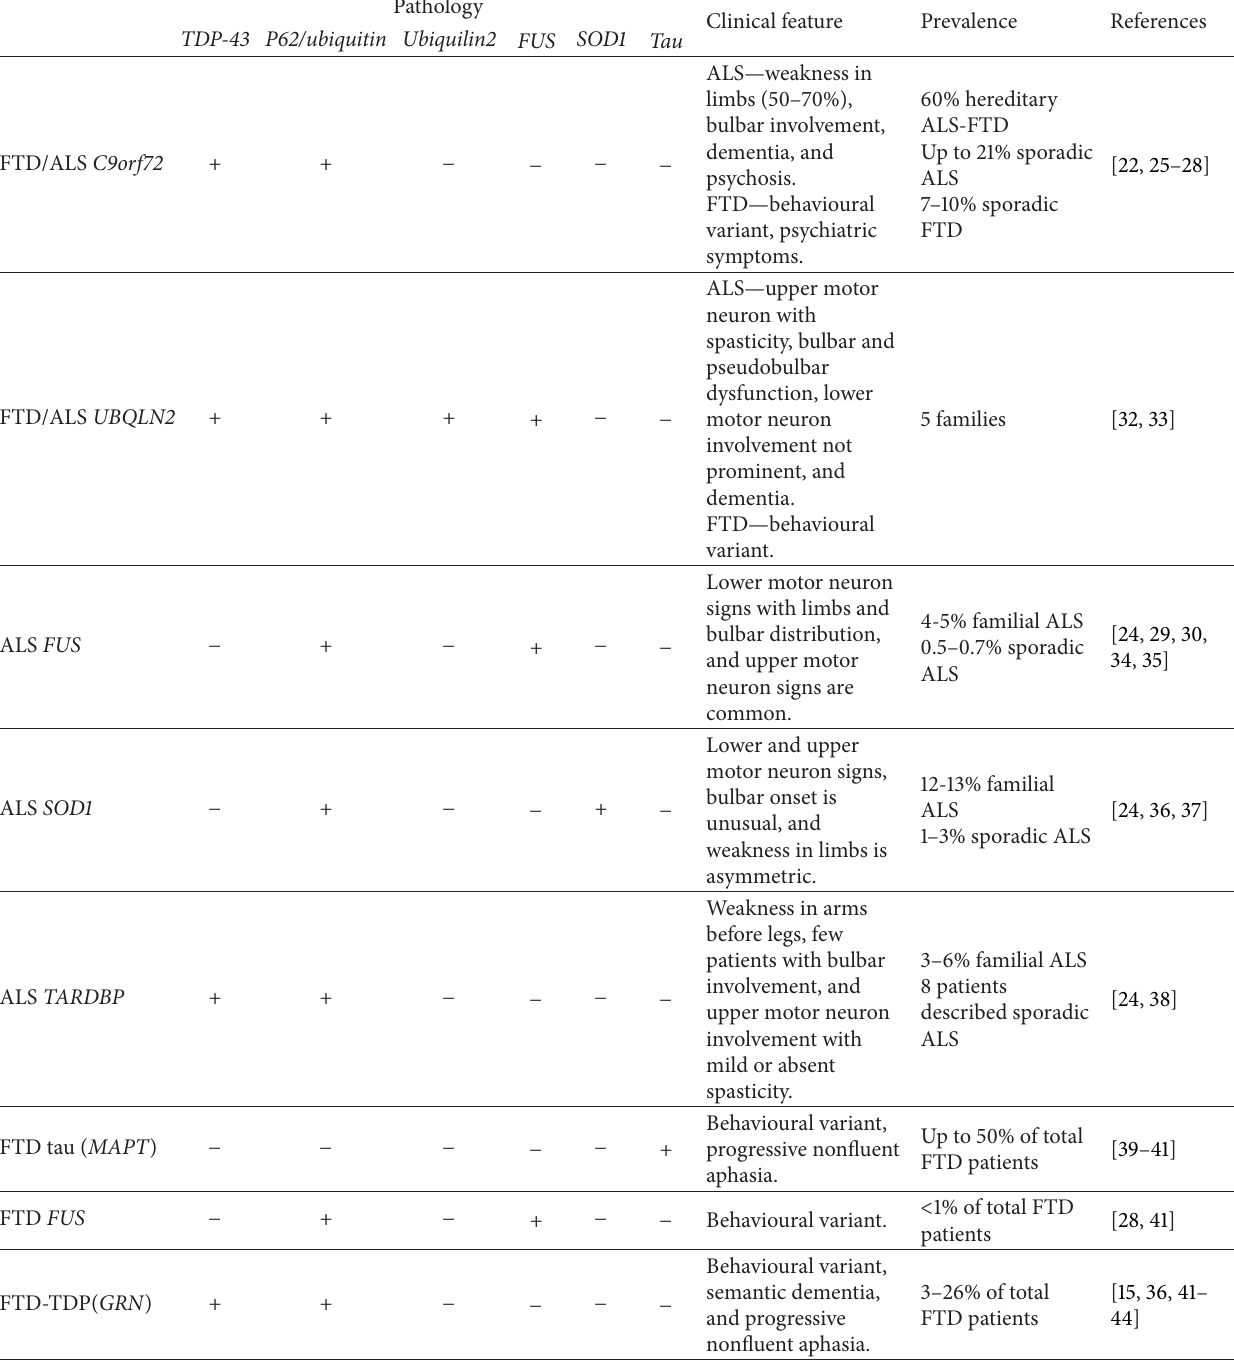
Table 1: Comparison of pathology, clinical features, and prevalence of distinct FTD and/or ALS causative